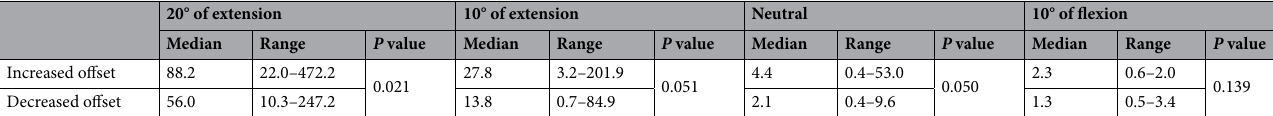
Table 6. Mean surface pressure (kPa) of the iliopsoas muscle when stem offset was changed. Values are shown as the median and range. The Wilcoxon signed-rank test was used for comparisons between stem offset